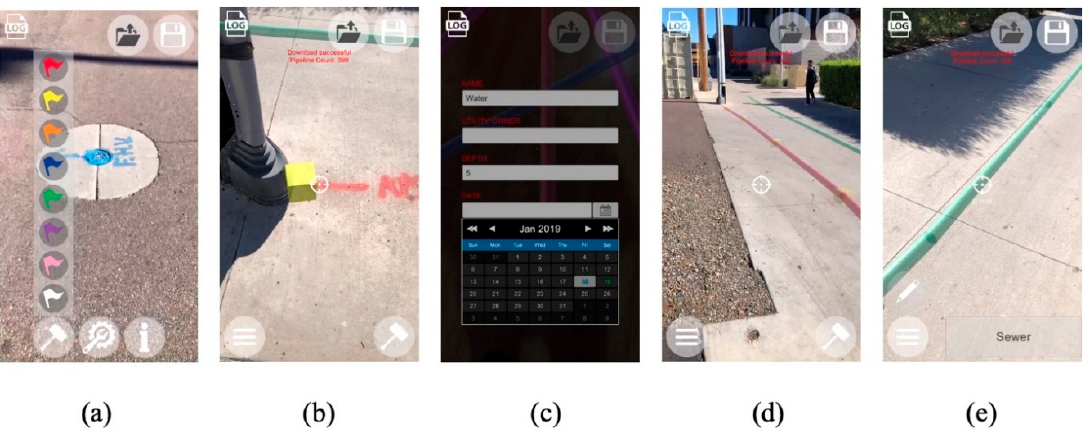
Figure 4. System user interface (UI): ( a ) main page selecting the type of utility; ( b ) registering utility location; ( c ) inputting utility information; ( d ) editing mode; ( e ) inspection mood showing the depth, location, and type of utility.